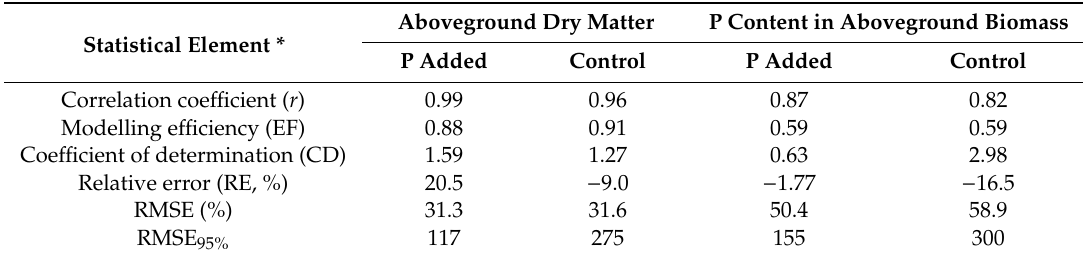
Table 2. Model performance statistics on comparisons between simulated and observed aboveground dry matter and phosphorus content in dry matter ( n = 14).